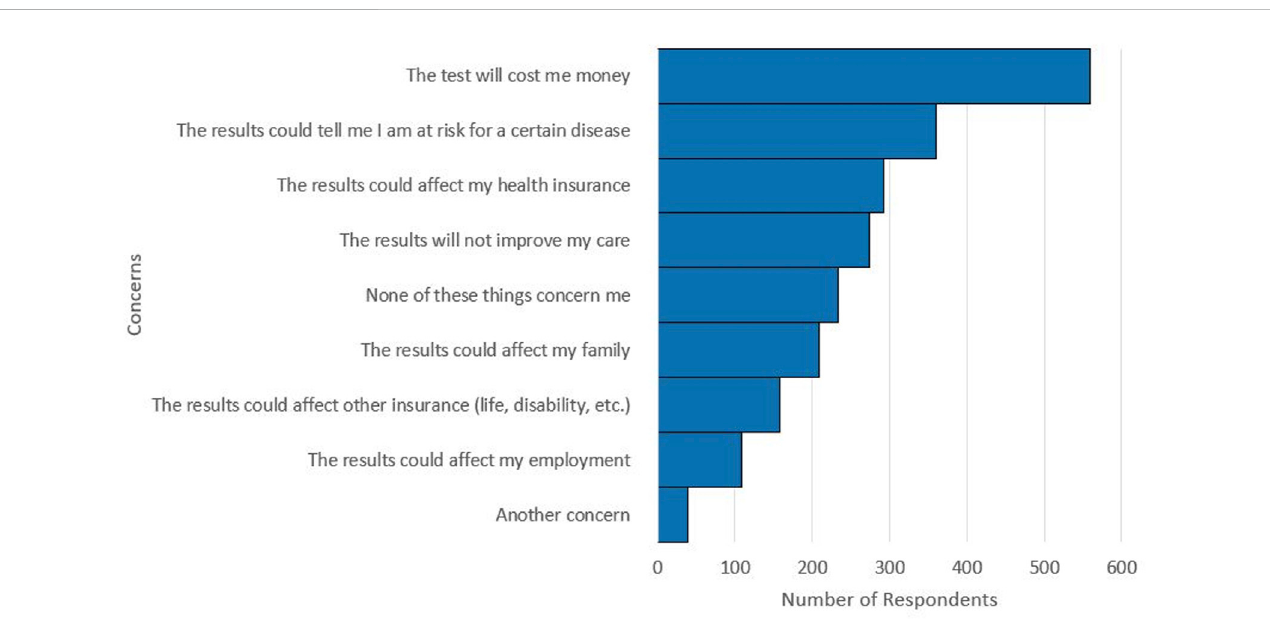
FIGURE 4 Respondent selectionsforconcernswithpharmacogenetic testing.Multipleconcernscouldbeselectedbyrespondents.A totalof2,234 concerns were selected by the 1,060